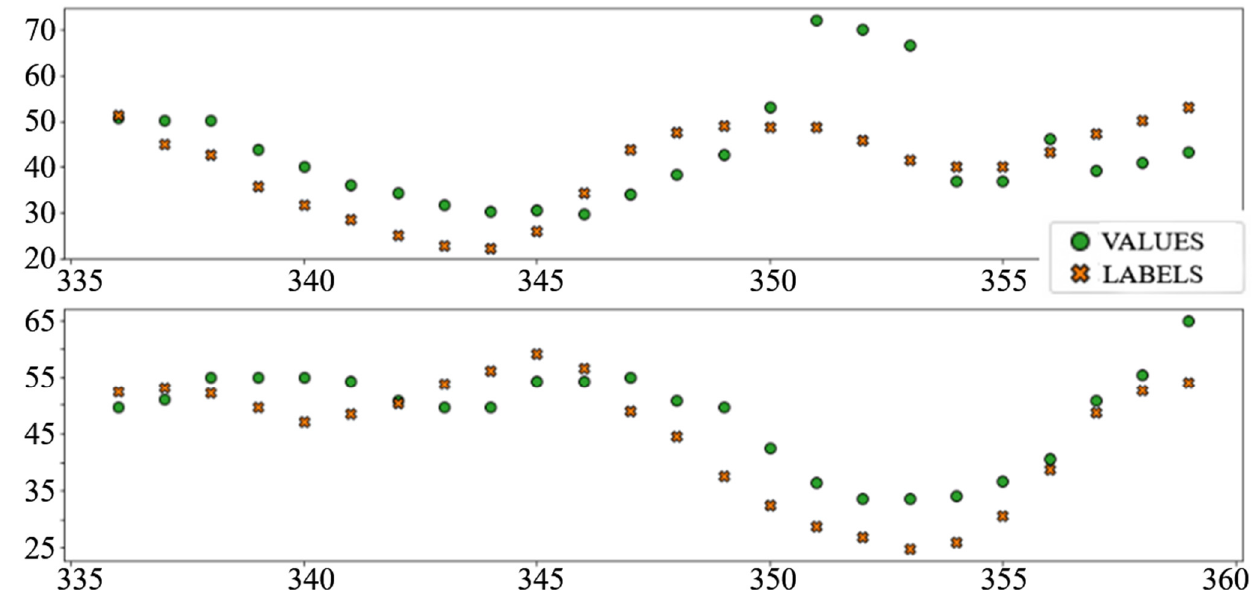
Figure 11. Price prediction examples: “TCN”.